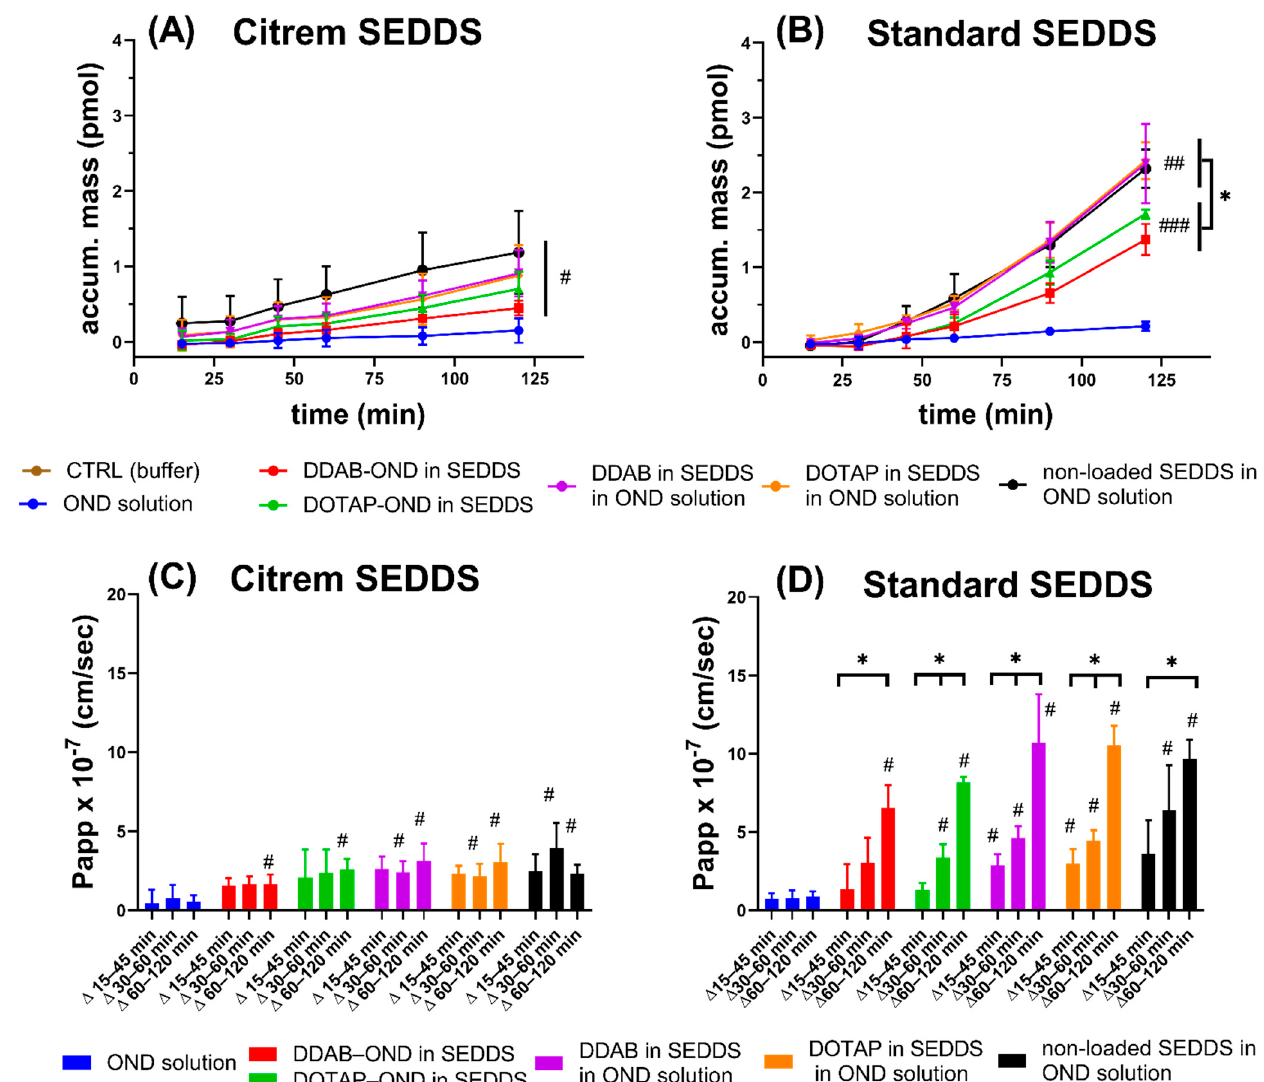
Figure 9. The transported OND accumulated in the basolateral compartment for Citrem SEDDS ( A ) and Standard SEDDS ( B ). The apparent permeability coefficient (P app ) values for specified time intervals in the Citrem SEDDS ( C ) and Standard SEDDS ( D ). ( A , B ) # , ## and ### represent significant differences of the flux curves of SEDDS-treated cells relative to the OND solution ( # p <0.05, ## p < 0.01 and ### p < 0.001). ( B ) * represents a significant difference between complex-loaded Standard SEDDS and a group of other Standard SEDDS formulations (* p < 0.05). ( C , D ) Bars marked by # showed a significant difference in the P app relative to the respective bars of the OND solution ( p < 0.05). ( D ) The significant differences between the time intervals in the Standard SEDDS is denoted as * p < 0.05. The results are presented as mean ± SD ( n = 5 to